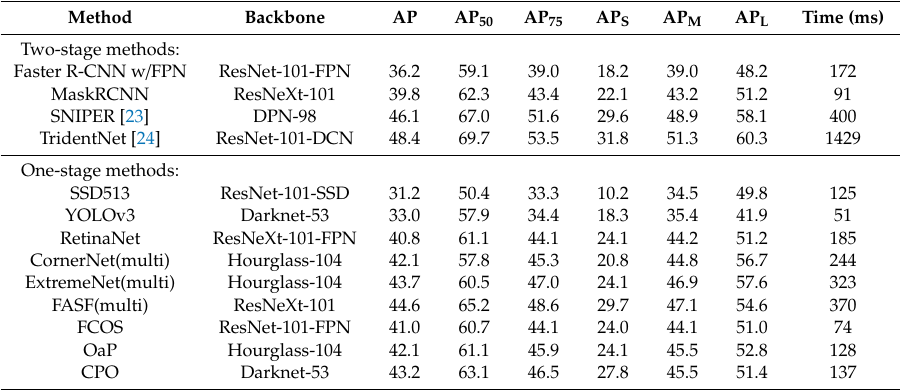
Table 4. CPO vs. other state-of-the-art detectors on COCO test-dev. (Top: two-stage detectors; bottom: one-stage detectors. Multi-scale test is conducted for most one-stage detectors).